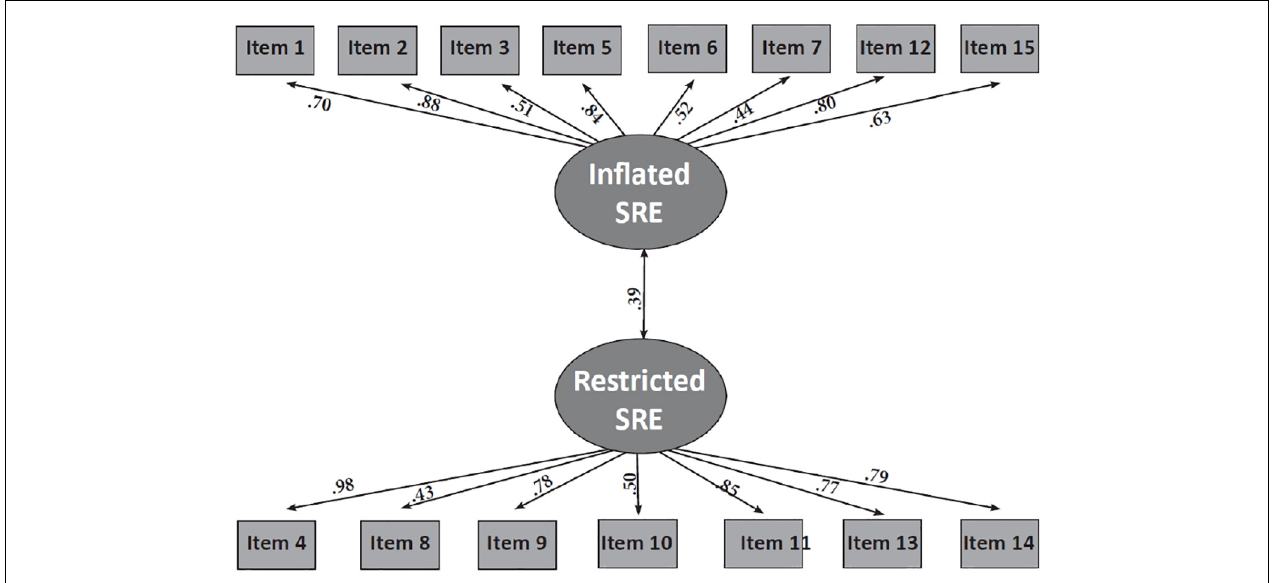
FIGURE 1 | CFA of the two-factor model for the SRE-R. All paths were statistically significant at p < 0.001. Latent variables are indicated by ellipses. Observed variables are indicated by rectangles. Arrows between latent variables signify correlations between latent variables. Correlations between latent and observed variables were significant at p <